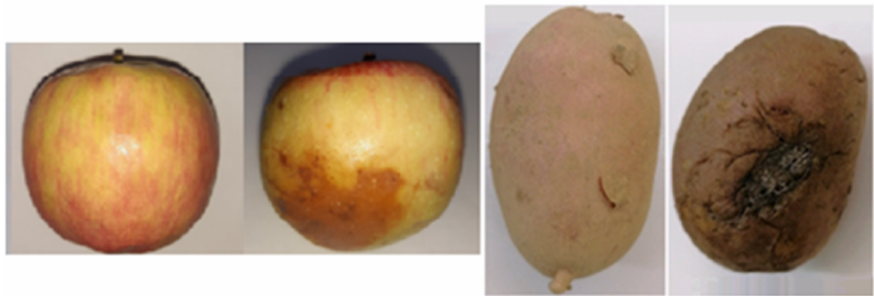
Figure 2. Apples and potatoes were used in experiments with continuous-wave fluorescence spec- troscopy. Healthy ( left ) and rotten ( right ) samples.